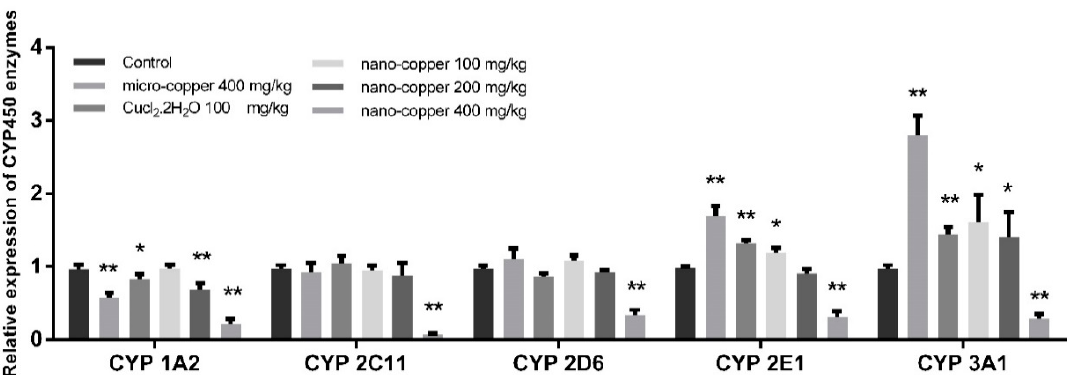
Figure 7. The mRNA levels of CYP450 enzymes in rat livers. * p < 0.05, ** p < 0.01. The expression of CYP450 enzymes were inhibited by nano-coper (200 mg/kg), but CYP 3A1 and CYP 2E1 were induced by Micro-copper, CuCl 2 and low doses of nano-copper.